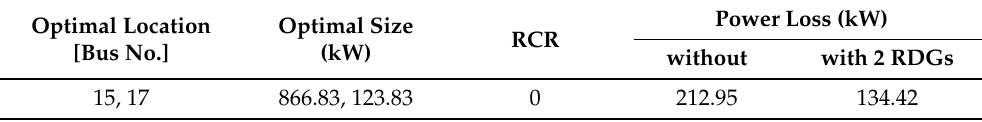
Table 8. Result for installing two RDGs of IEEE 33-bus distribution test